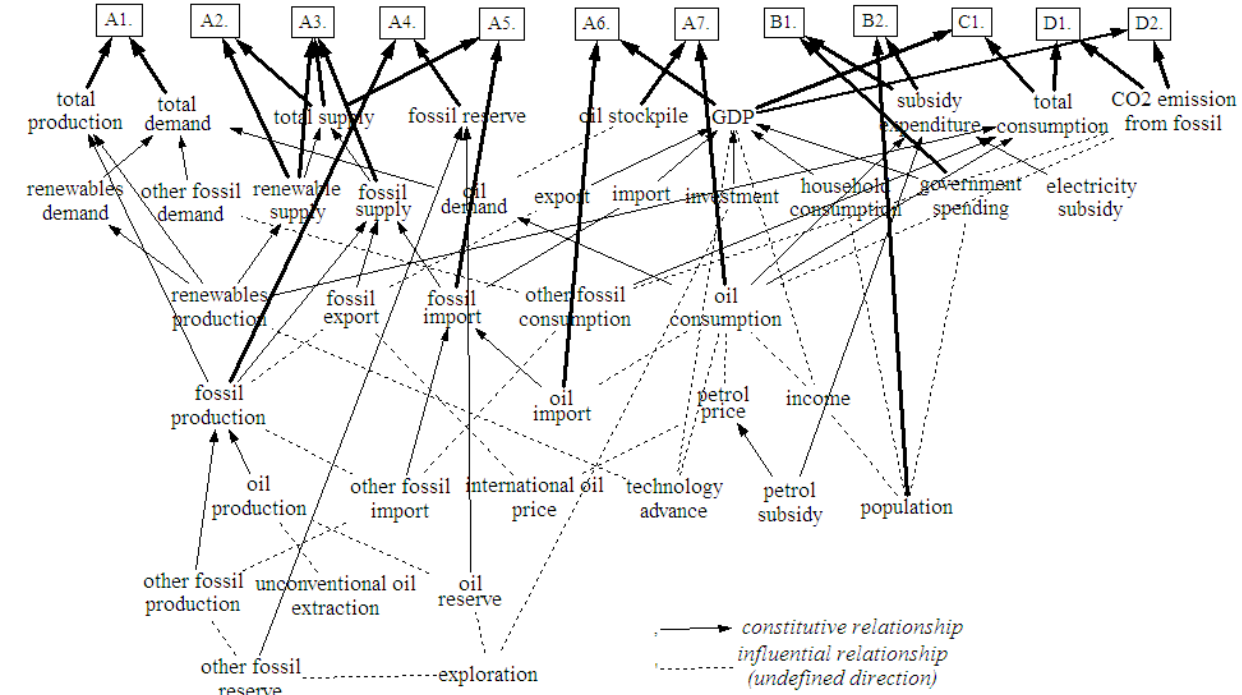
Figure 1. Defining Indonesia’s model (thick arrows represent relationships between indicators and